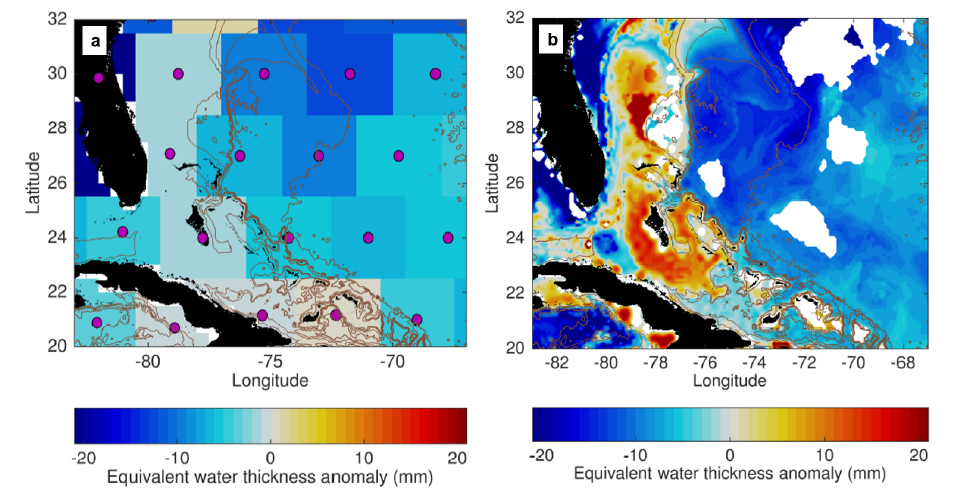
Figure 2. ( a ) GRACE OBP anomaly (in units of equivalent water thickness anomaly) in the subtropical western Atlantic, March 2010, from the JPL RL06M mascon product bandpassed for 3–12 month timescales. Brown contours indicate bathymetry at intervals of 1000 m. ( b ) Same but for the downscaled GRACE OBP anomaly with depth adjustment. Areas without shading did not have at least 3 mascons in the set G , as described in Section 2.2.